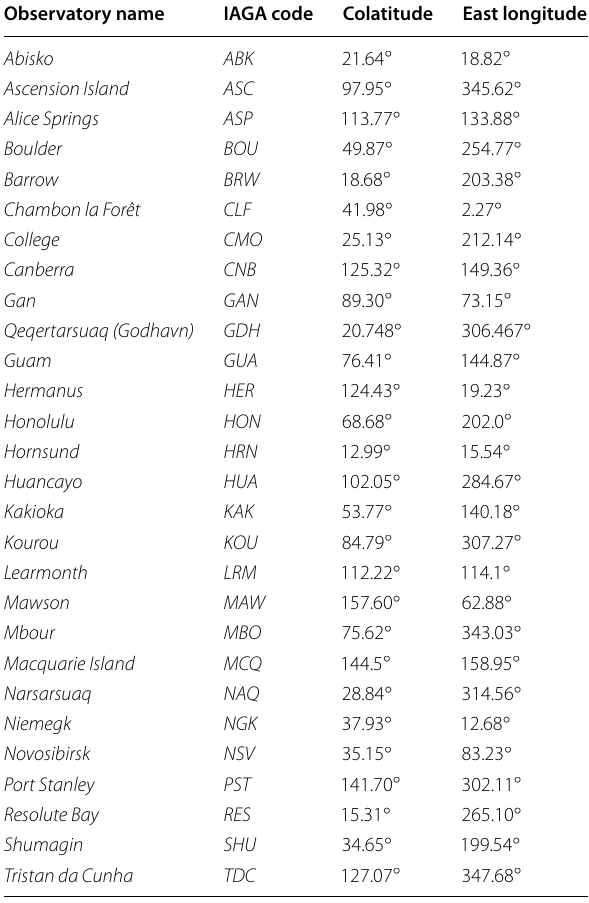
Table 2 List of the selected ground observatories